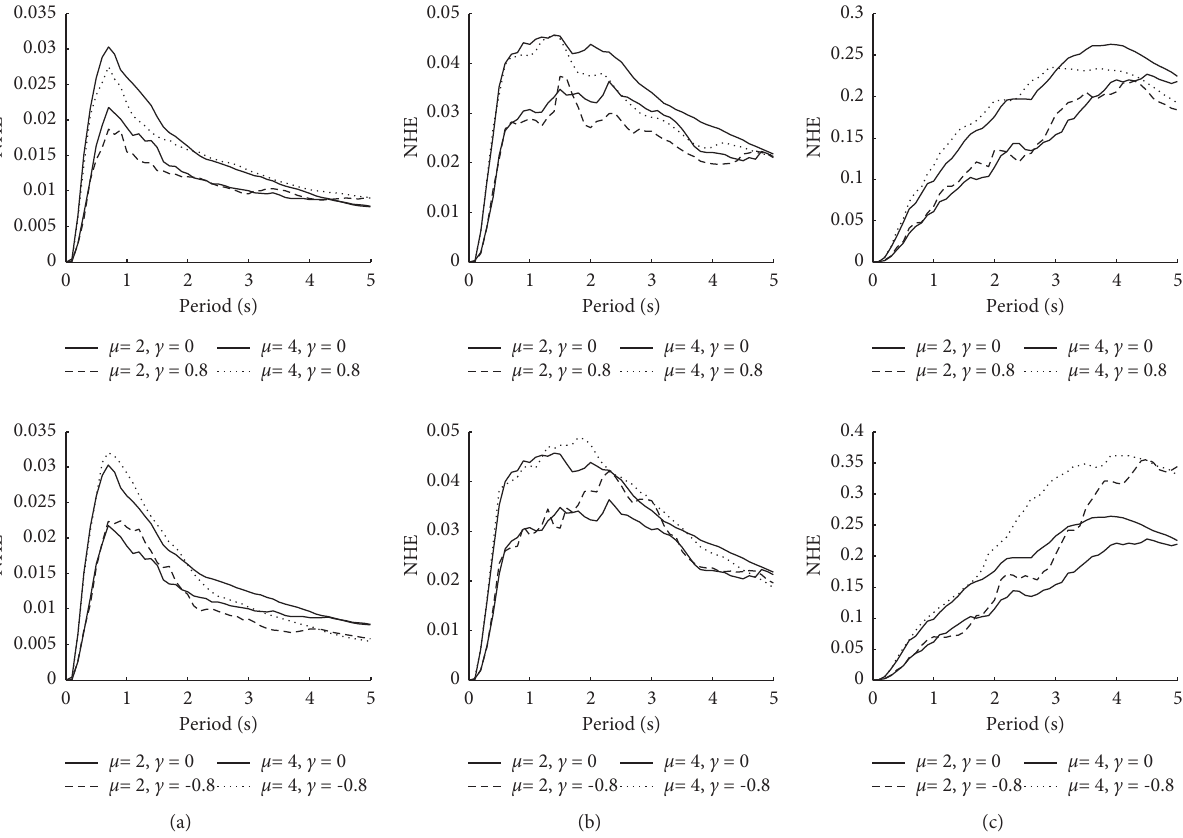
Figure 5: Comparison of NHE spectra between original one-directional GMs ( c � 0) and superposition of bidirectional GMs ( c � 0.8and − 0.8) ( ξ � 0.05). (a) Hard soil site. (b) Intermediate hard (soft) soil site. (c) Soft soil